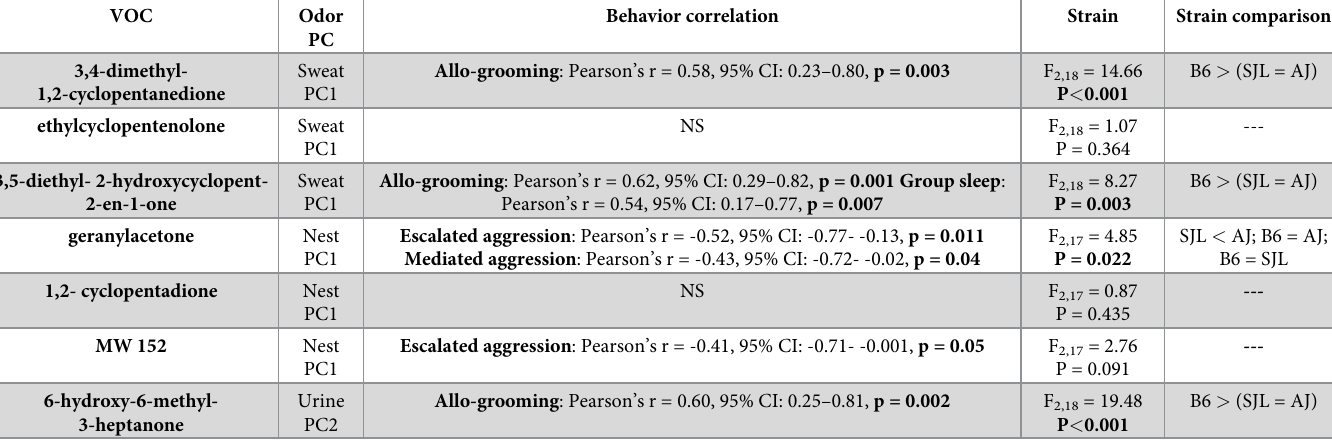
Table 5. Relationship between behavior, strain, and high loading VOCs from sweat PC1, nest PC1, and urine